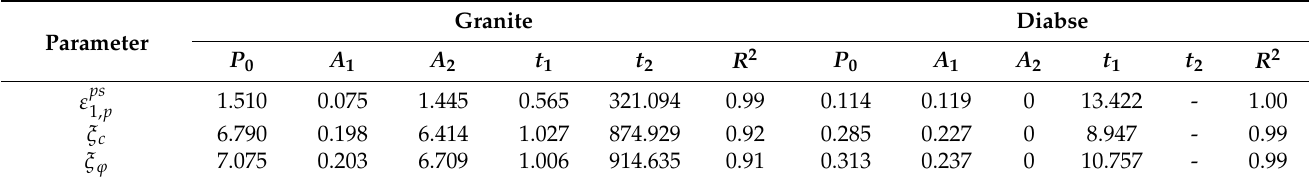
Table 4. Fitting coefficient of parameters ε ps pressure